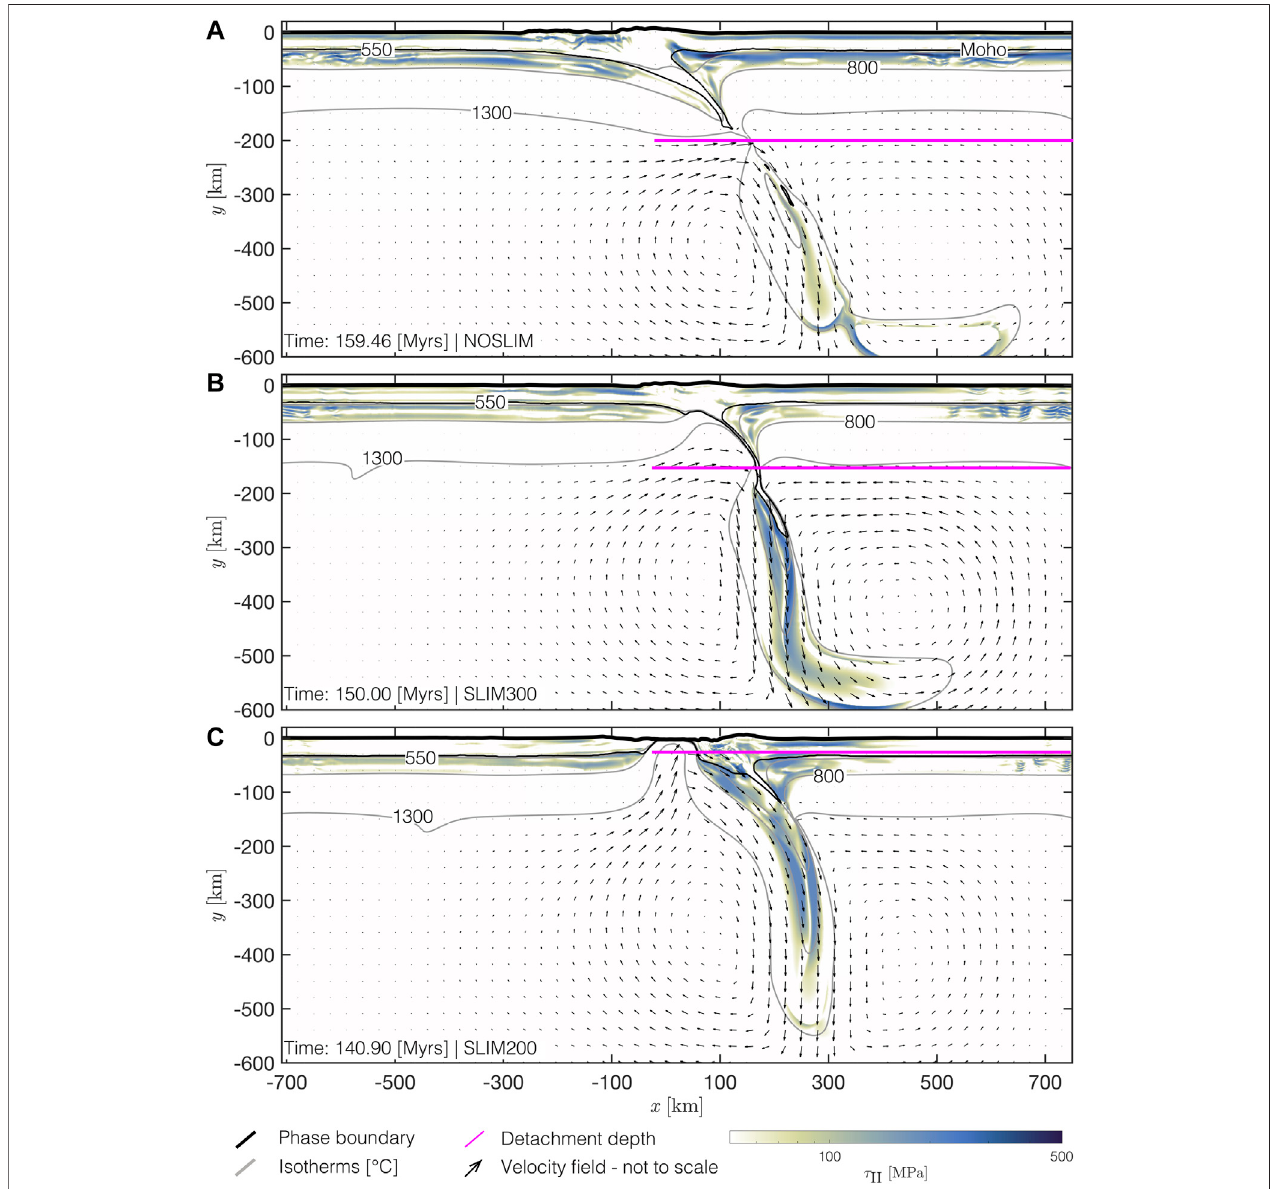
FIGURE9| Depthofslabdetachmentsformodelswithdifferentappliedstresslimits.Whitetodarkblueisthesecondinvariantofdeviatoricstresstensor,solidgrey lines are several isotherms, glyphs show the velocity fi eld calculated by the numerical algorithm, solid black lines indicate the crustal phase boundary and the solid magenta line marks the approximate depth of slab detachment. For a weak plate [low stress limit, (B,C) ], the slab detachment occurs earlier in model history and at shallower depth compared to a strong plate [no stress limit, (A) ].